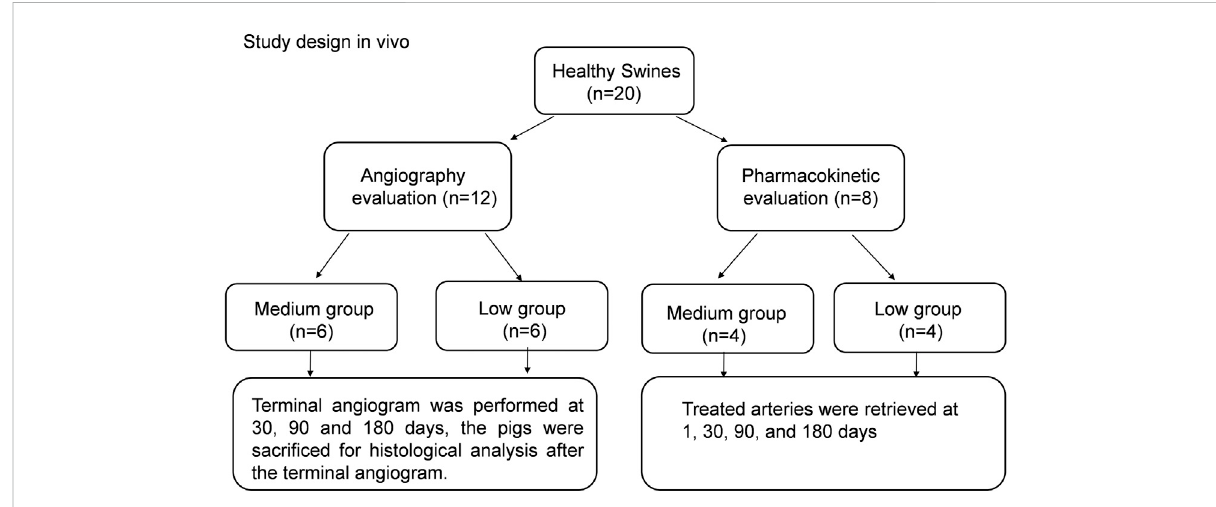
FIGURE 1 Study design in vivo . Angiography evaluation and pharmacokinetic study.